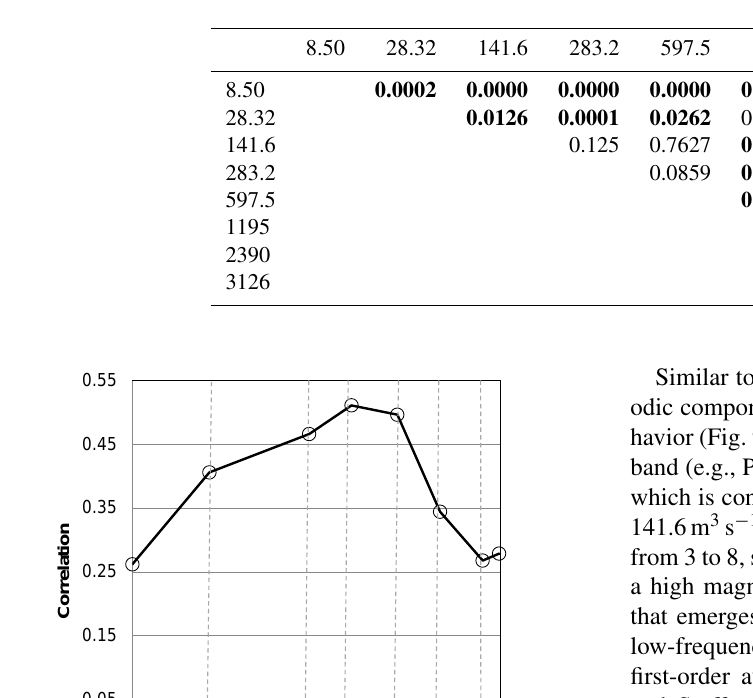
Table 3. Mann–Whitney U test p values amongst all combinations of Z and W j ; bold values are at the 95% level.